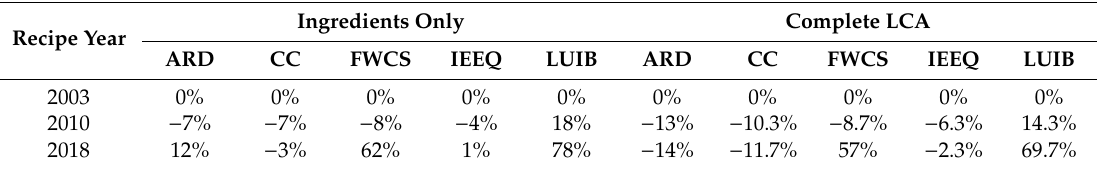
Table 1. Changes in the five environmental impact indicators in the 2003–2018 period for the product average- analysis of ingredients alone versus the complete